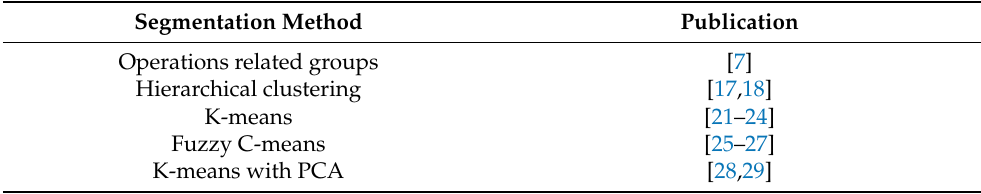
Table 1. Approaches to SKU segmentation.